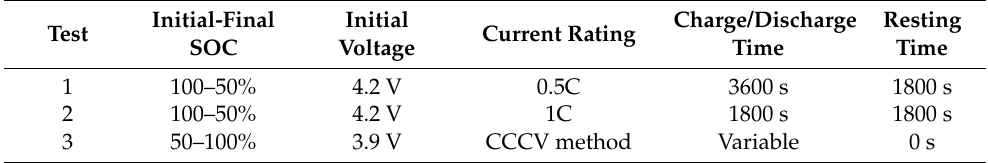
Table 2. Test plan